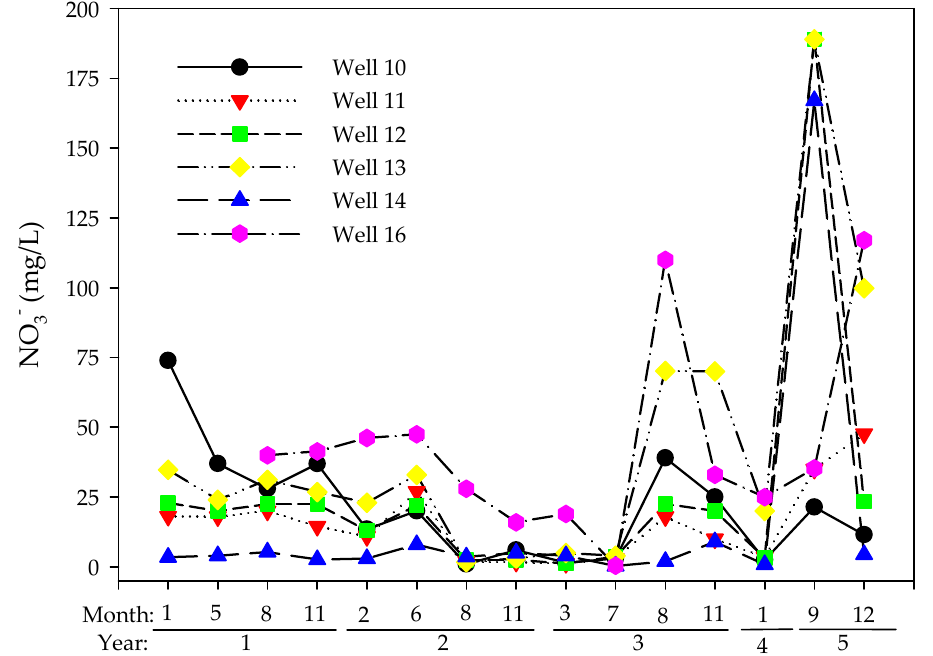
Figure 8. Time evolution in the levels of nitrates in waters from wells 10–14, and 16, over the five year test period.